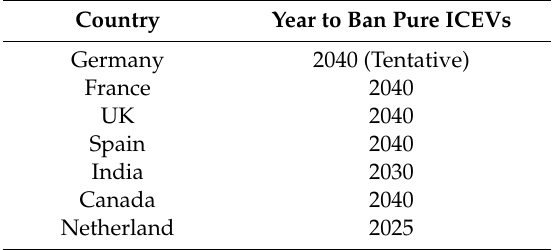
Table 1. Planned ban on pure internal combustion engine vehicles (ICEVs) [4]. Country Year to Ban Pure ICEVs 2040